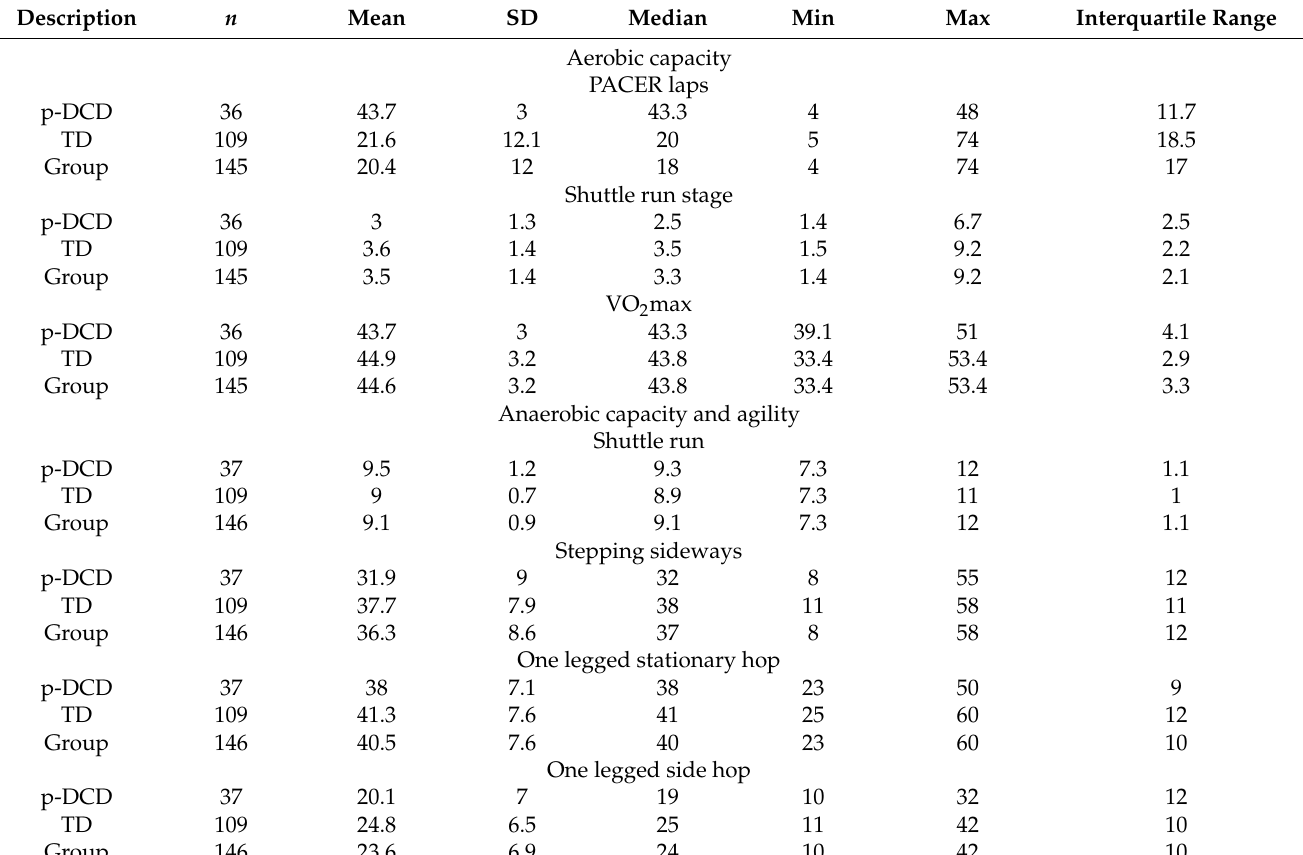
Table 3. Mean, standard deviation, median, minimum and maximum values, and interquartile range for health-related fitness (aerobic and anaerobic capacity, muscular strength, and body composition) for the two